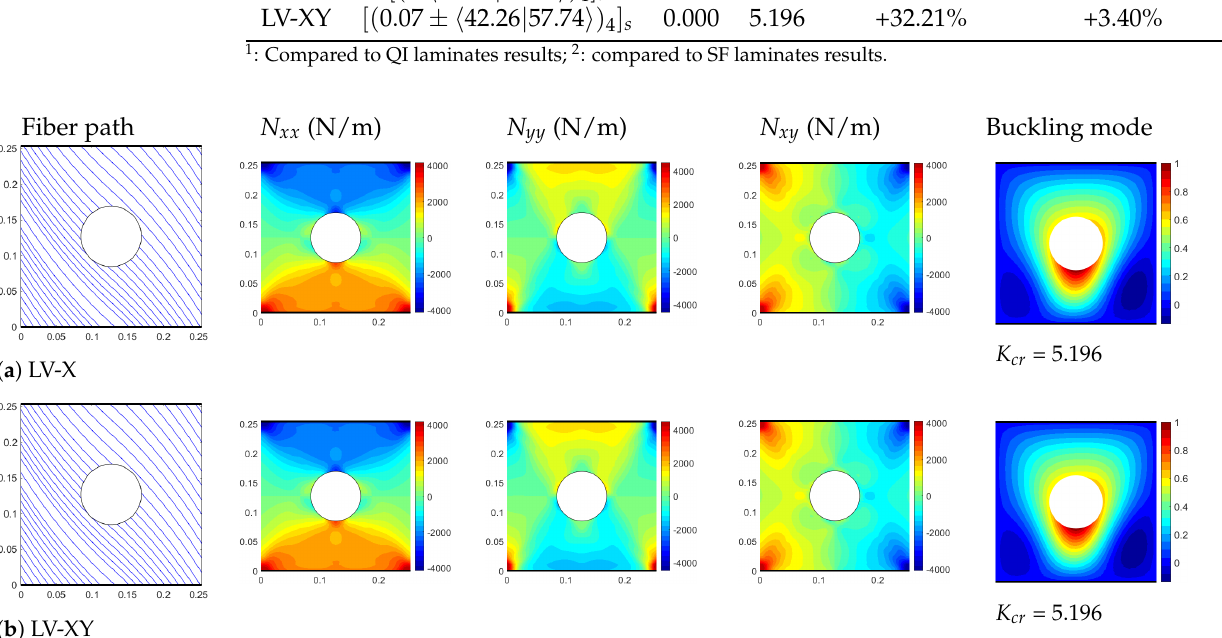
Figure 22. Comparison of optimal fiber paths, stress resultants, and buckling modes for different study cases of the stiffened VAT laminates with a central hole under in-plane bending displacements considering manufacturing constraints. ( a ) LV-X laminate design; ( b ) LV-XY laminate